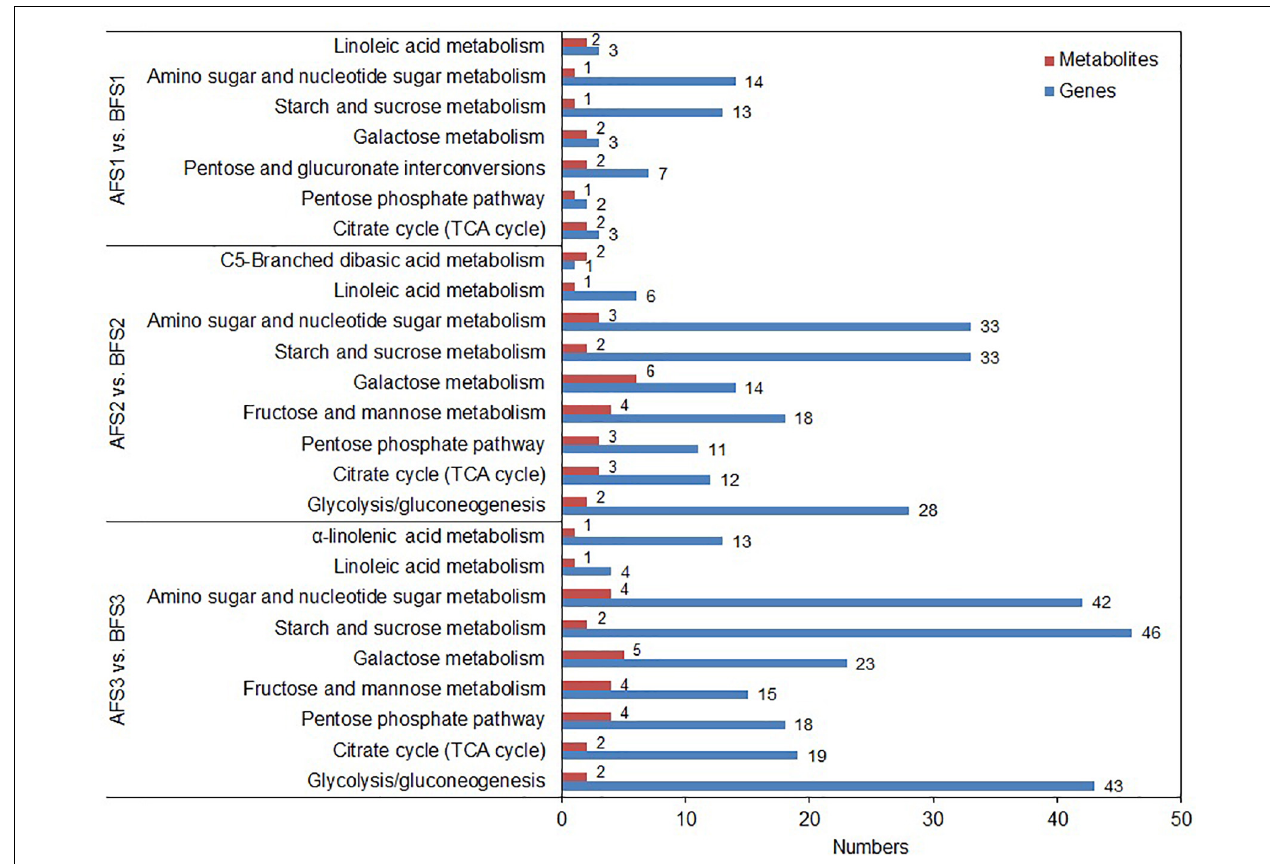
FIGURE 4 | Integrated analyses of the transcriptome and metabolome of the KEGG pathways related to sugars and organic acids. Three comparison groups of AFS1 vs. BFS1, AFS2 vs. BFS2, and AFS3 vs. BFS3 are selected. The specific name of the KEGG pathway is provided on the left of the bar chart, and the numbers of relative DEGs and DAMs are on the right of the